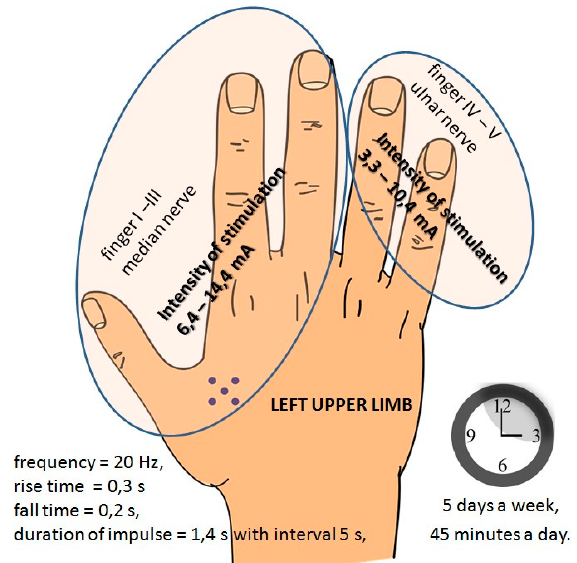
Figure 6. Neural connections between particular fingers and human organs and parameters of the stimulation.